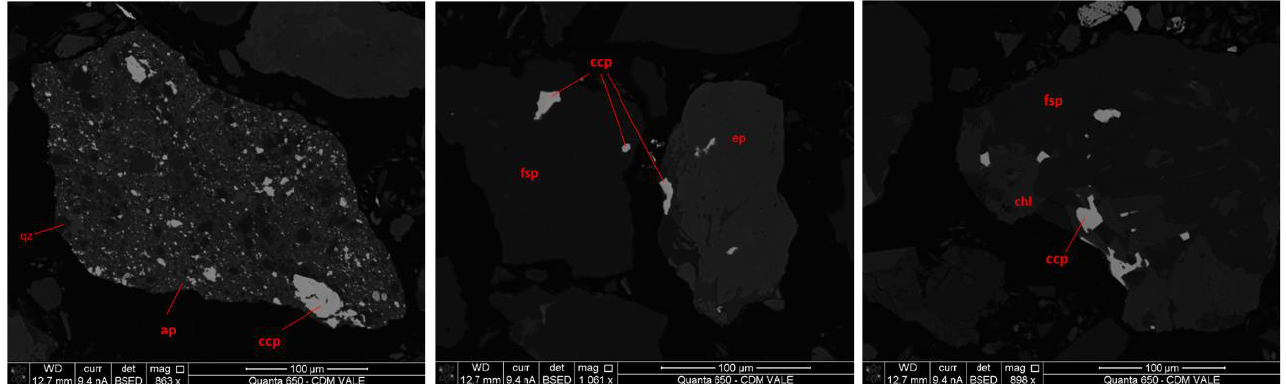
Figure 17. Backscattered electron images of the rougher tailings of sample 6y-4m-3.35 × 1, showing chalcopyrite (ccp) grains locked in silicates particles (feldspar, fsp; epidote, ep; quartz, qz, apatite, ap, chlorite, chl). Complete list of acronyms and chemical formulas in Table S1.